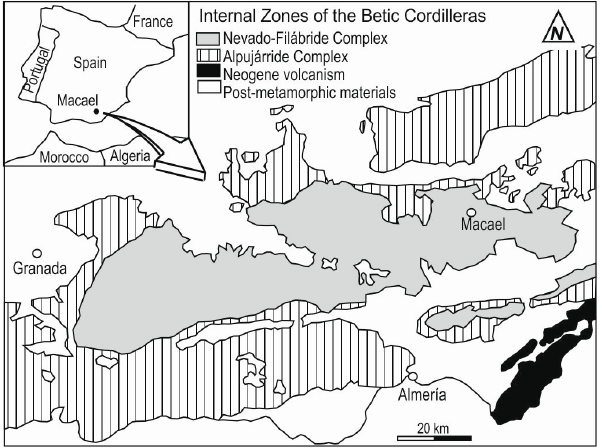
Figure 1. Simplified geological map of the inner zones of the Baetic System showing the location of the study region ([17]).